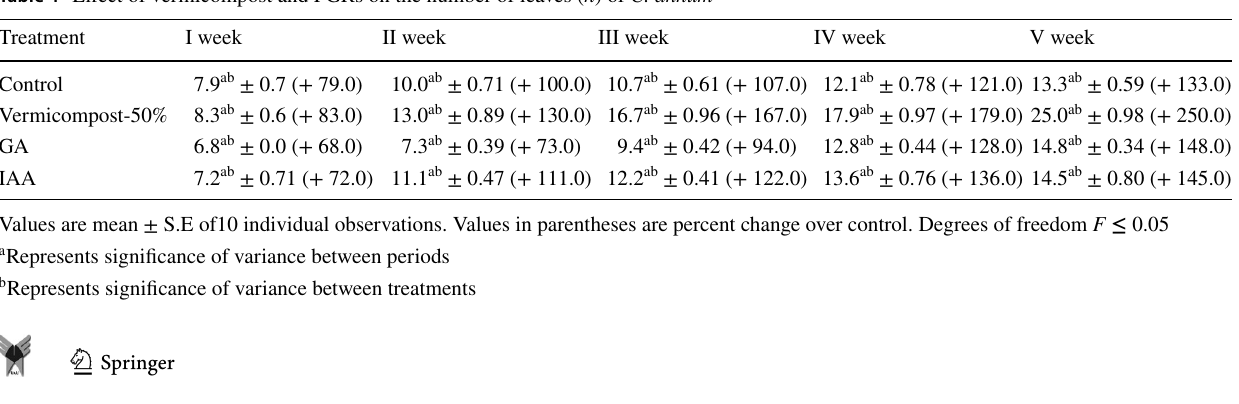
Values are mean ± S.E of 10 individual observations. Values in parentheses are percent change over control. Degrees of freedom F ≤ 0.05 a Represents significance of variance between periods b Represents significance of variance between Table 4 Effect of vermicompost and PGRs on the number of leaves ( n ) of C. annum